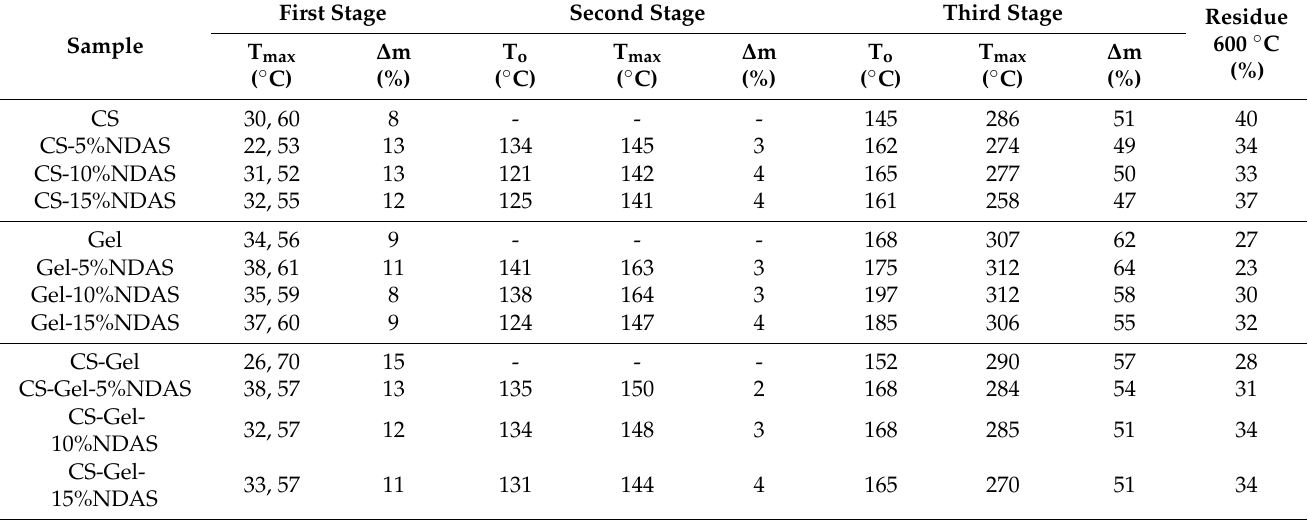
Table 1. Thermal parameters of neat chitosan (CS); gelatin (Gel); chitosan–gelatin (CS-Gel, 1:1); and these films cross-linked by 5%, 10%, and 15% addition of NDASs (TGA-DTG analysis in a nitrogen